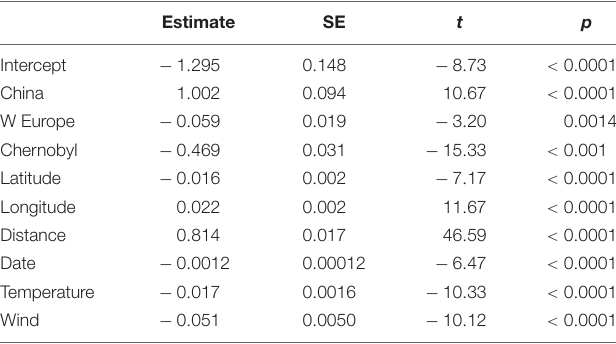
TABLE 1 | Generalized Linear Mixed Model (GLMM) of the abundance of insects in relation to wind speed, temperature, date, distance, longitude, latitude, Chernobyl, Western or Eastern Europe and China or Europe.